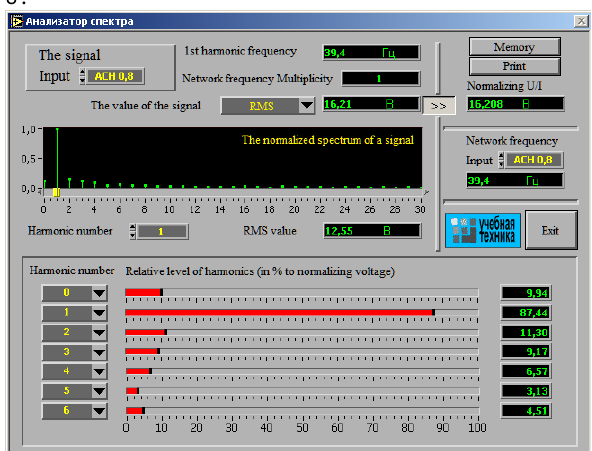
Figure 7. Harmonic composition of the excitation voltage.